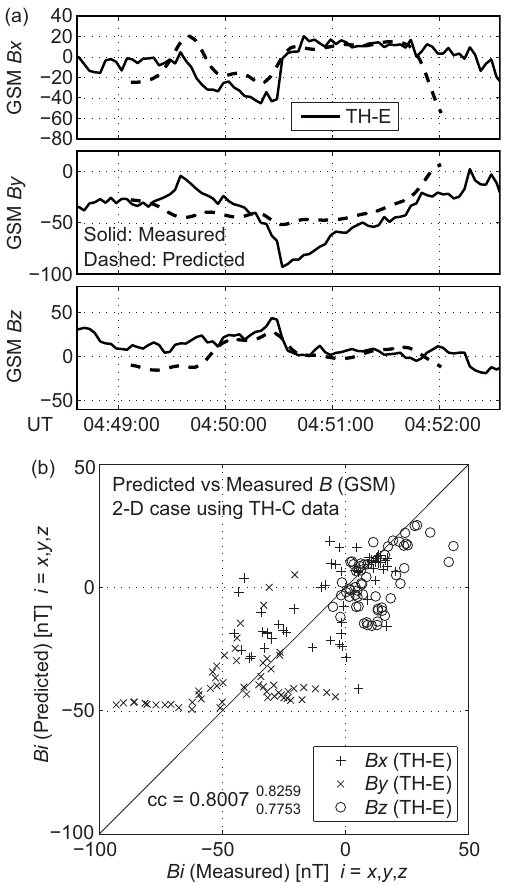
Figure 6. The same as Fig. 3 but for the 2-D Grad–Shafranov re- construction using the THC data. The field variations along only the THE path are shown.